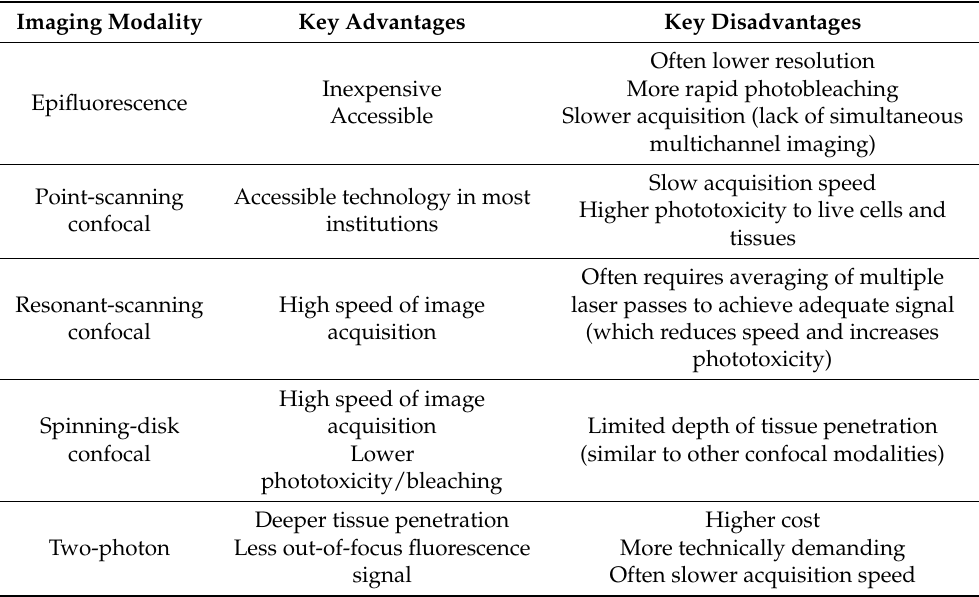
Table 1. A comparison of common intravital microscopy